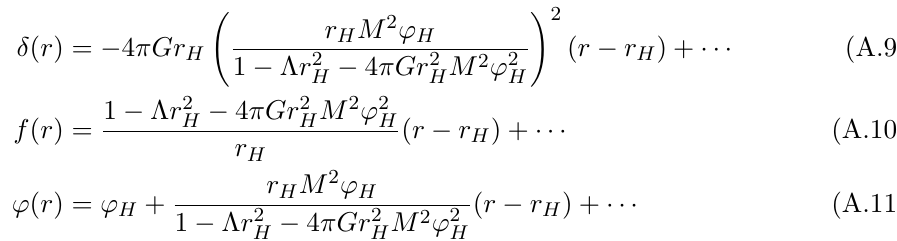
q √ 1 − Λ r 2 = 1 / G < b ϕ 4